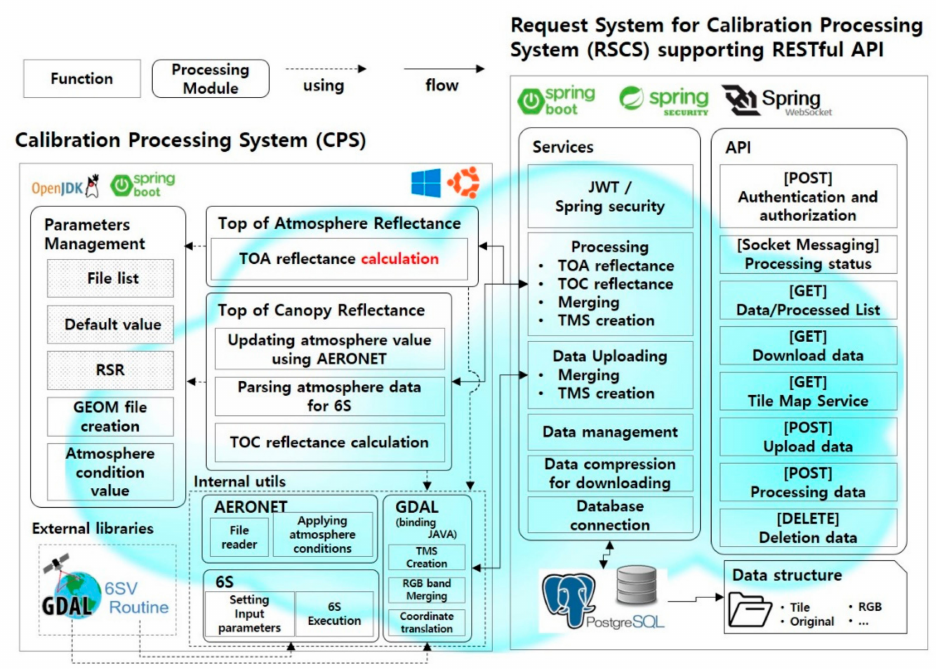
Figure 3. Main features and processing modules for CPS and RSCS with data